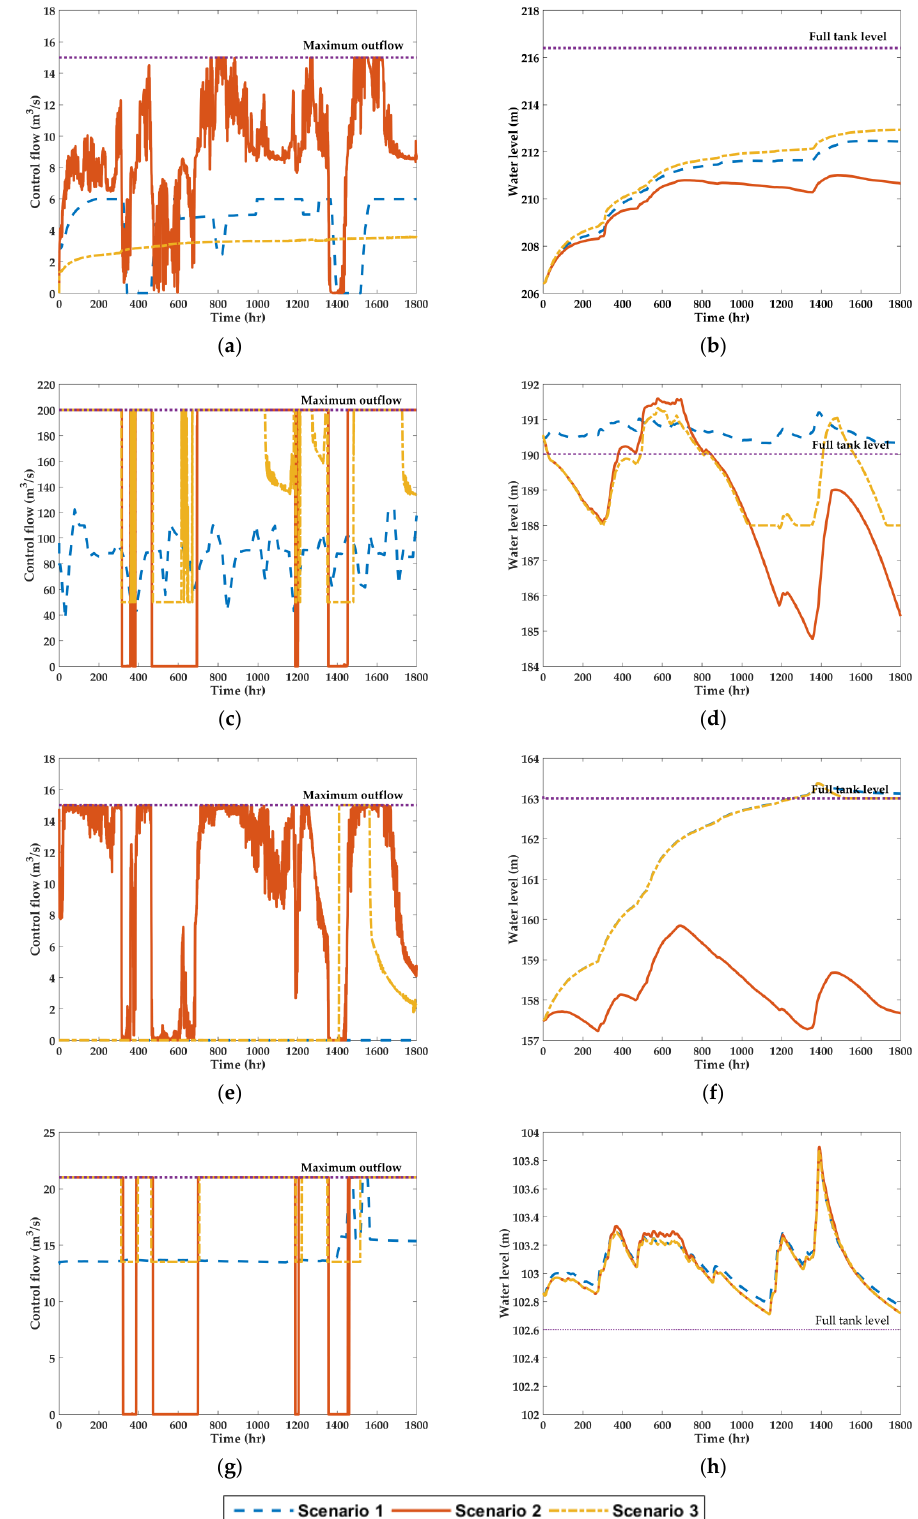
Figure 4. Control flows and water levels with respect to three operation scenarios based on four selected reservoirs: ( a , b ) Sinthe reservoir; ( c , d ) Lower Paunglaung reservoir; ( e , f ) Ngalaik reservoir; and ( g , h ) Swa reservoir.